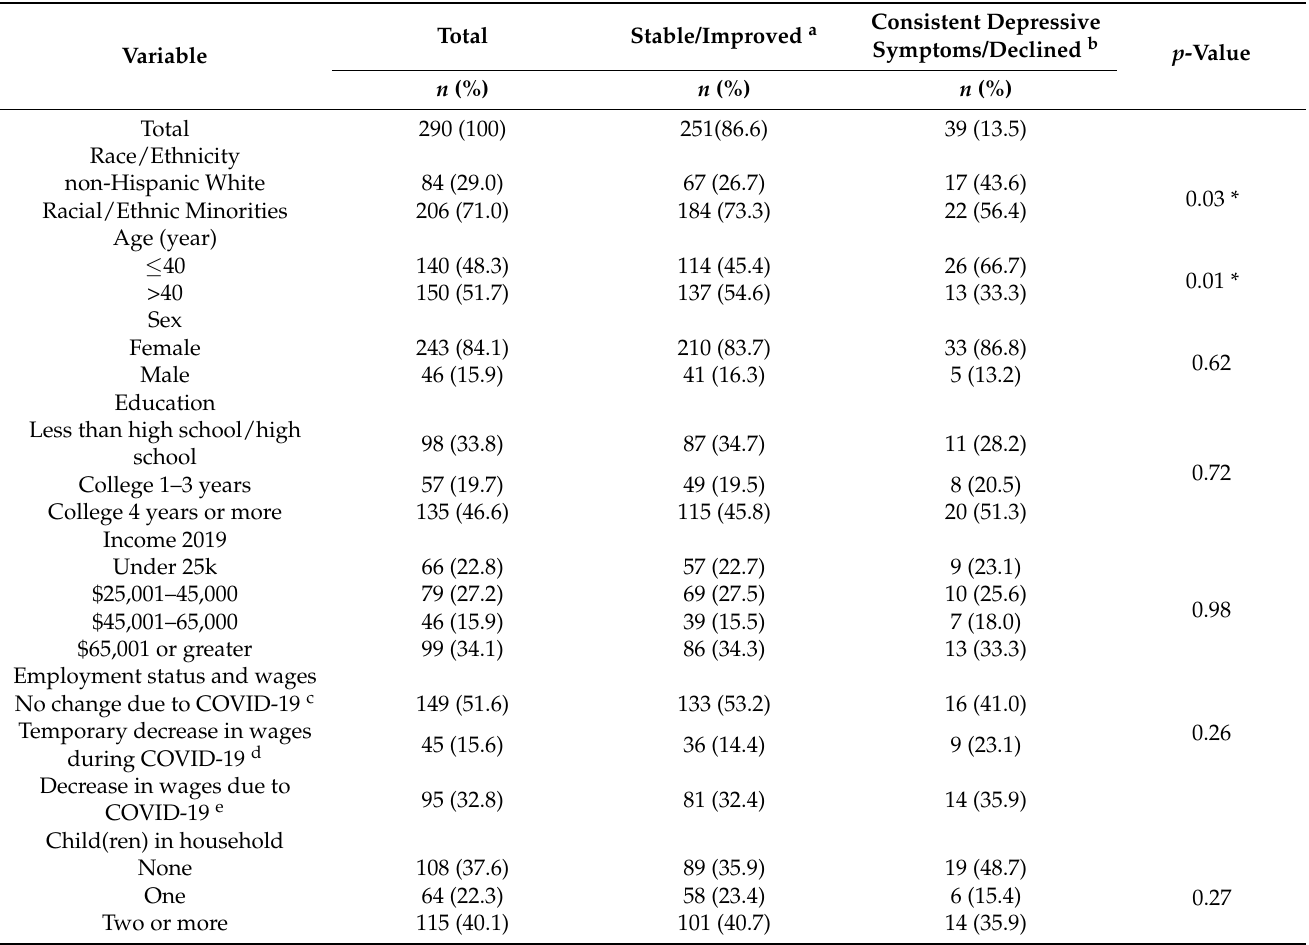
Table 1. Demographic, behavioral and health outcome variables during COVID-19 among